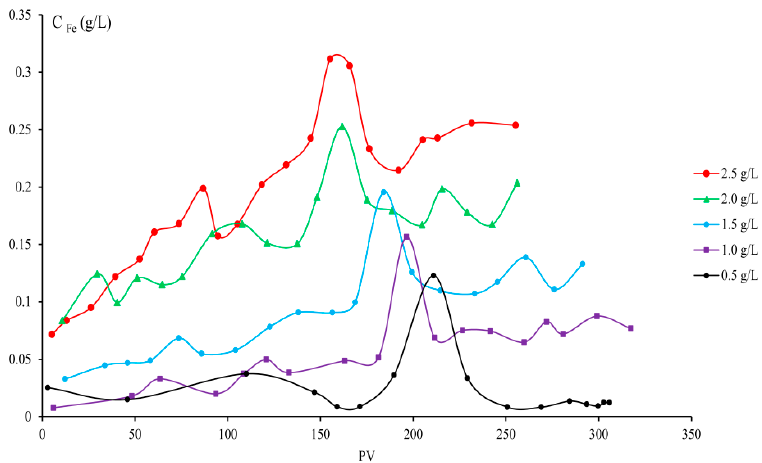
Figure 6. Breakthrough curves of iron in succession tests of different injected concentrations. PV represents pore volume, C Fe represent iron concentration in the effluents. Solid points and lines in red, green, blue, purple, and black represent C 0 = 2.5, 2.0, 1.5, 1.0, and 0.5 g/L,